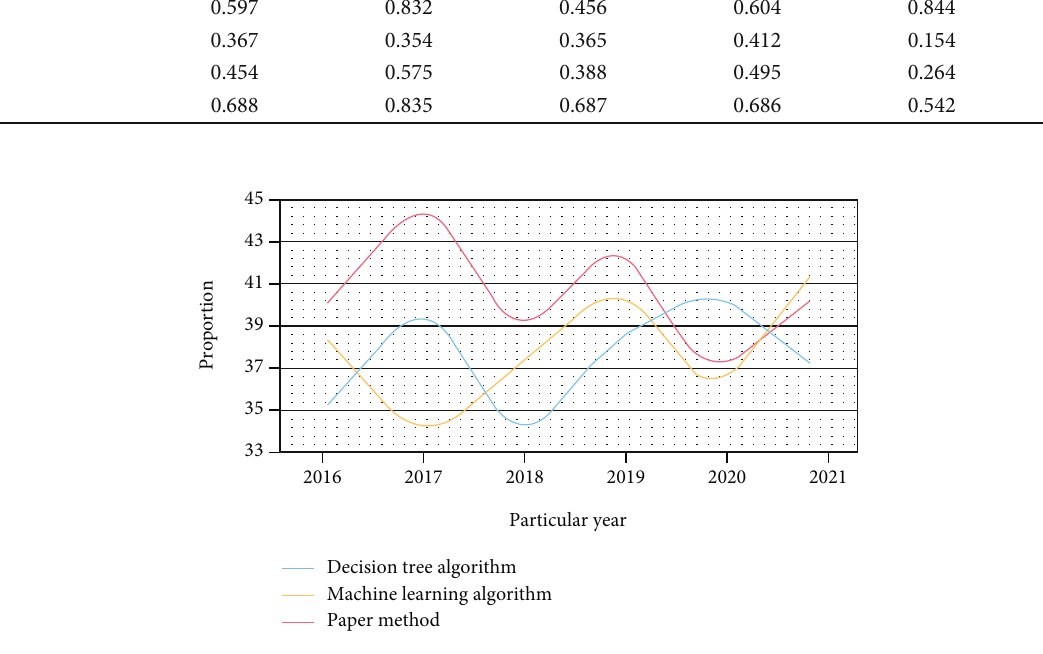
Figure 3: Number of times of live work in distribution network of power grid factory.